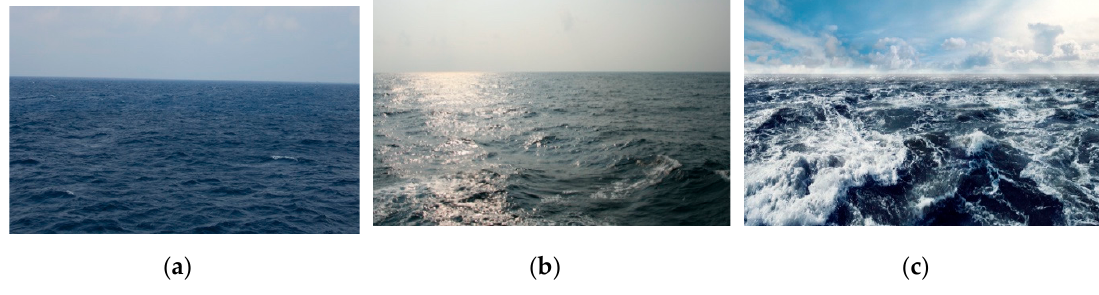
Figure A1 . Background with different condition, ( a ) calm; ( b ) sparkling; ( c ) rough.